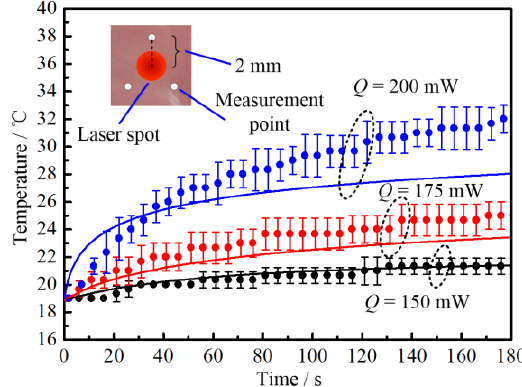
Figure 4. Temperature response of in vitro biological tissue under different laser intensities. Solid lines are simulated results. Scattered circles with error are experimental results. The inset indicates the laser irradiated spot (red circle) and measurement positions (white circles).